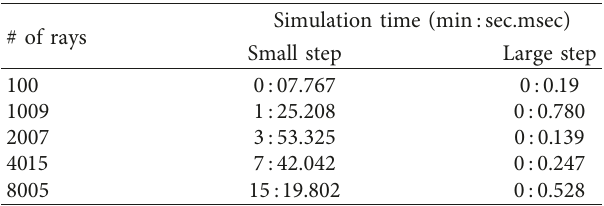
Figure 8: Progressive view of ray vector marching per frame inside uncladded POF. (a) Frame 1st. (b) Frame 4th. (c) Frame 7th. (d) Frame 10th. (e) All vectors. (f) Round-off error in small-step version. Table 3: Simulation speed comparison between small-step and large-step